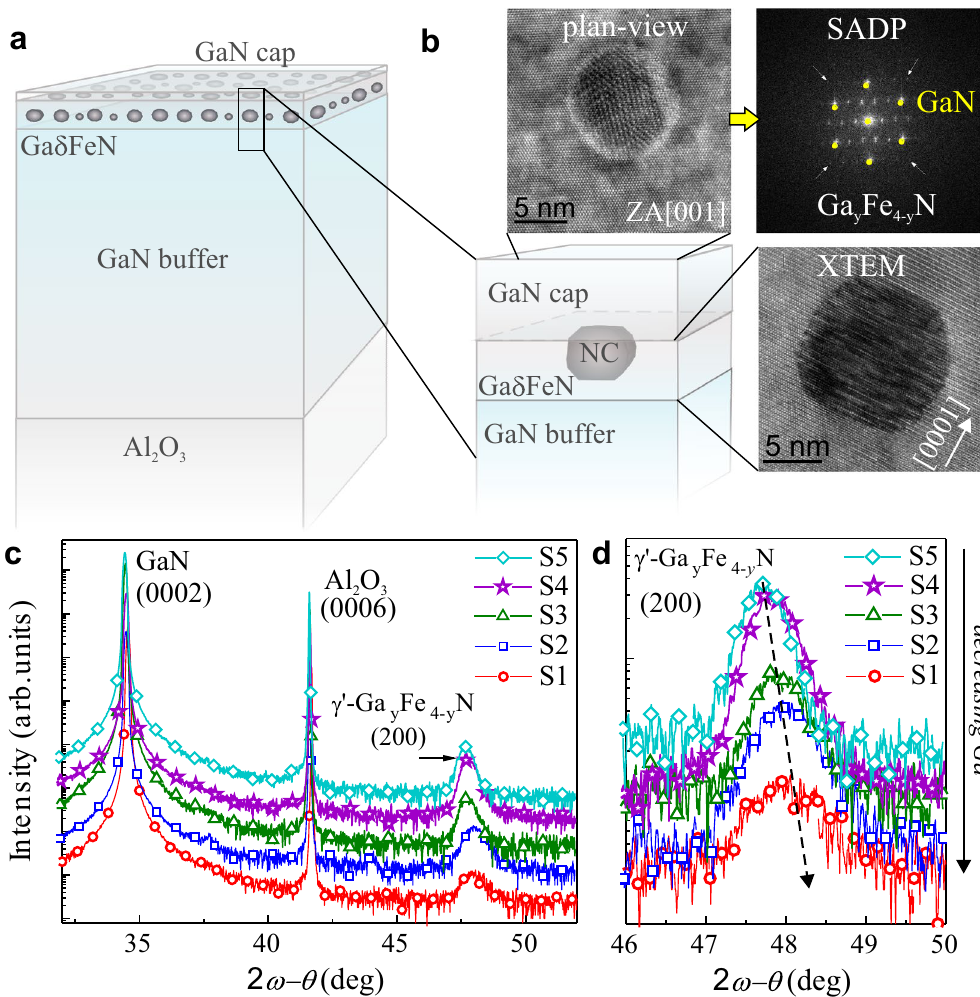
Figure 1. ( a ) Schematic structure of the phase-separated Ga δ FeN layers. ( b ) Detail of a nanocrystal and its surroundings with corresponding plan-view TEM, SADP and cross-section TEM (XTEM) image. ( c ) Radial 2 θ - ω HRXRD scans of the investigated samples. ( d ) Detail of the scan in ( c ) showing the shift of the (200) γ ′ - Ga y Fe 4 − y N diffraction peak to larger angles, i.e smaller lattice parameter along the c -growth direction, with decreasing normalized Ga flow.